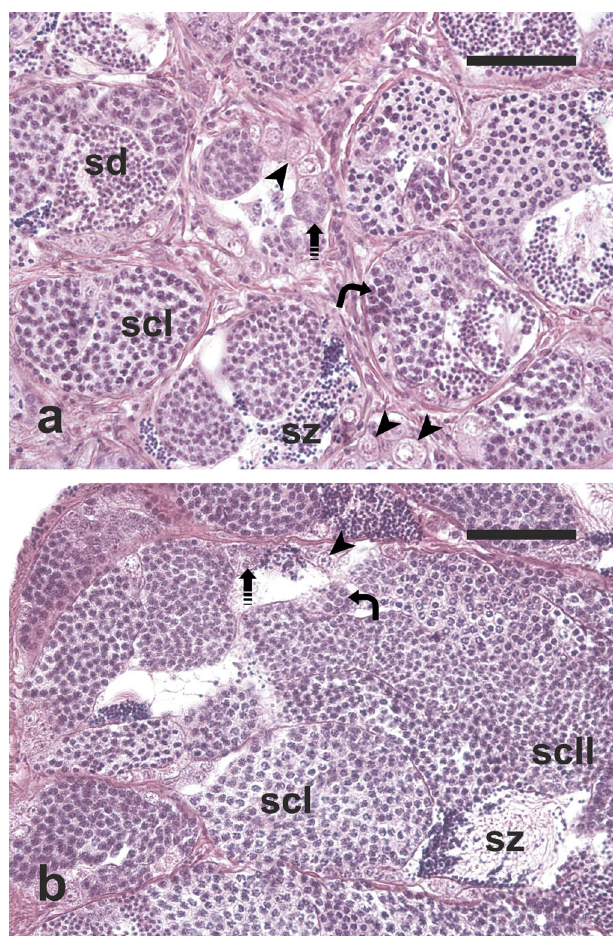
Figure 3. Micrographs of testis sections from ( a ) a juvenile meagre treated with saline solution for 6 weeks (CONTROL 6 group) and ( b ) a juvenile fish treated with rFsh for 6 weeks (TREATED group). H–E staining. Magnification bars = 50 μm. Arrowhead = single type A spermatogonium; dashed arrow = type A spermatogonial cyst; curved arrow = type B spermatogonial cyst; scI = primary spermatocyte cyst; scII = secondary spermatocyte cyst; sd = spermatid cyst; sz = spermatozoa.